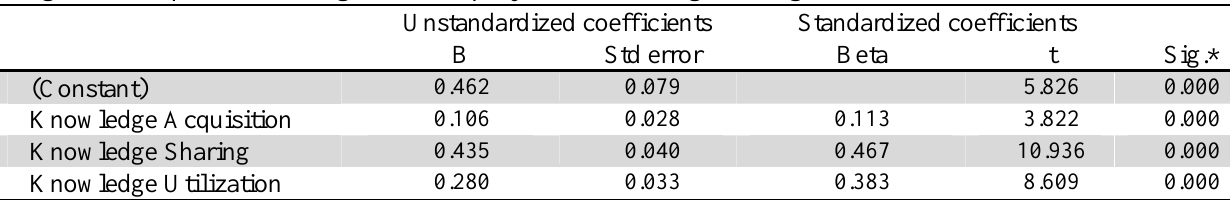
Regression equation- Dialogue and Inquiry and knowledge management Unstandardized coefficients Standardized